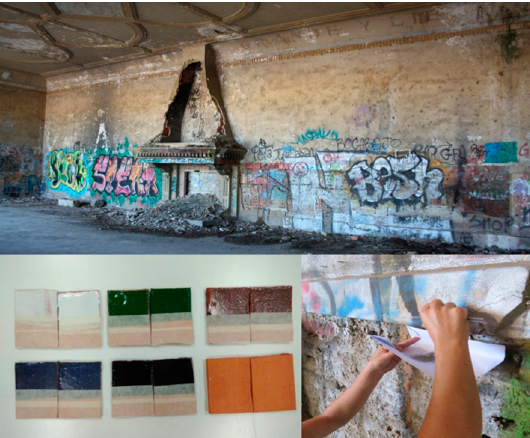
Figure 1. (Top) photograph of the main hall of the Punta Begoña Galleries showing the graffiti covering the entire surface of the marble and mural paintings, up to a height of approximately 2 m; (bottom left) mock-ups with the applied commercial sprays; (bottom right) example of the sampling of the inks in the main hall.